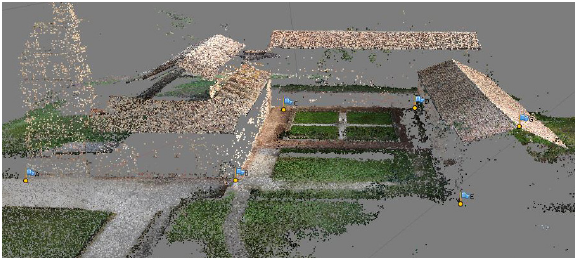
Figure 9. View of the sparse cloud of homologous points automatically recognized within nadiral photographs captured using the UAV equipment, and related GPC.